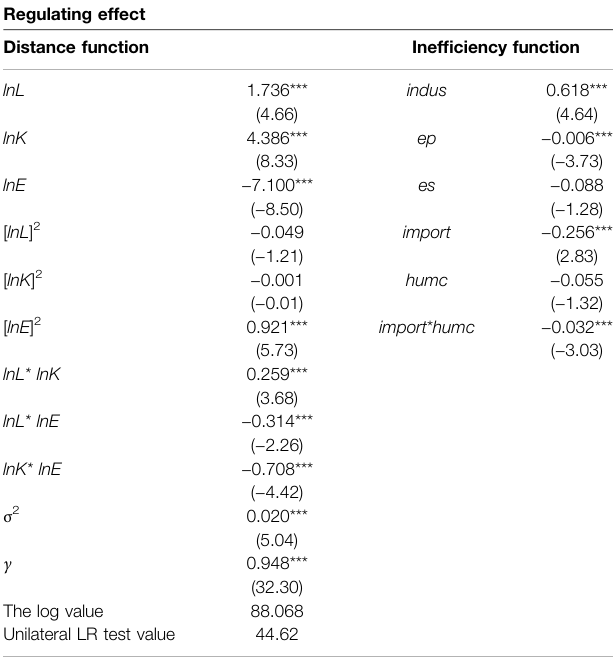
TABLE 3 | Estimated results of regulating effect of human